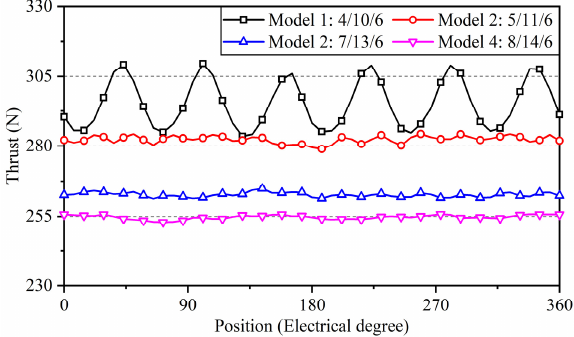
Figure 12. The magnetic flux density distribution of DCB ‐ VRLMs with different combinations of